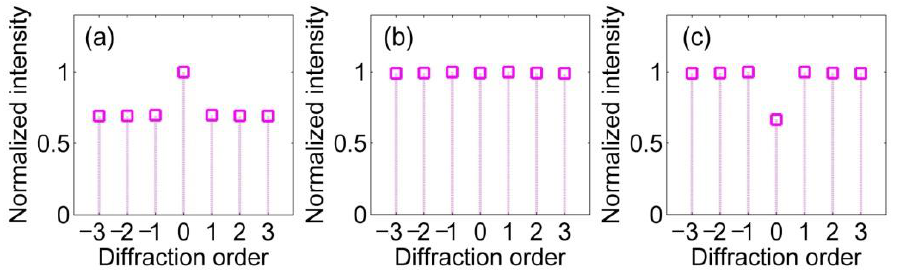
Figure 4. Simulated reconstructed intensity distribution of the designed non 0-π DOE for 1 × 7 beam splitting with etching depth of ( a ) 530 nm; ( b ) 560 nm; ( c ) 590 nm.